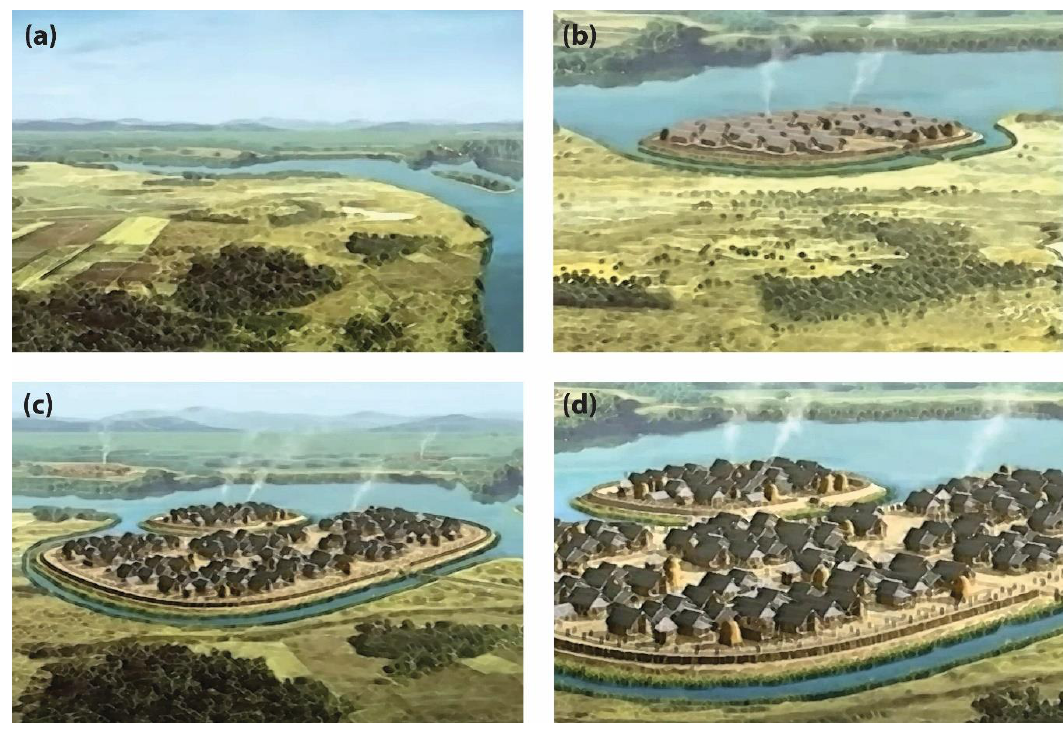
Figure 1. Reconstruction of a Terramara development (Santa Rosa di Poviglio, [47], modified by authors). ( a ) Landscape view before the settlement; ( b )” Villaggio Piccolo”: a little settlement surrounded by ditch and palisade, later destroyed and covered by a rampart. ( c ) “Villaggio Grande”: expansion of the small village with new fortified part with ditch and rampart. ( d ) Particular of the settlement at its maximum development, when small and big villages coexisting.